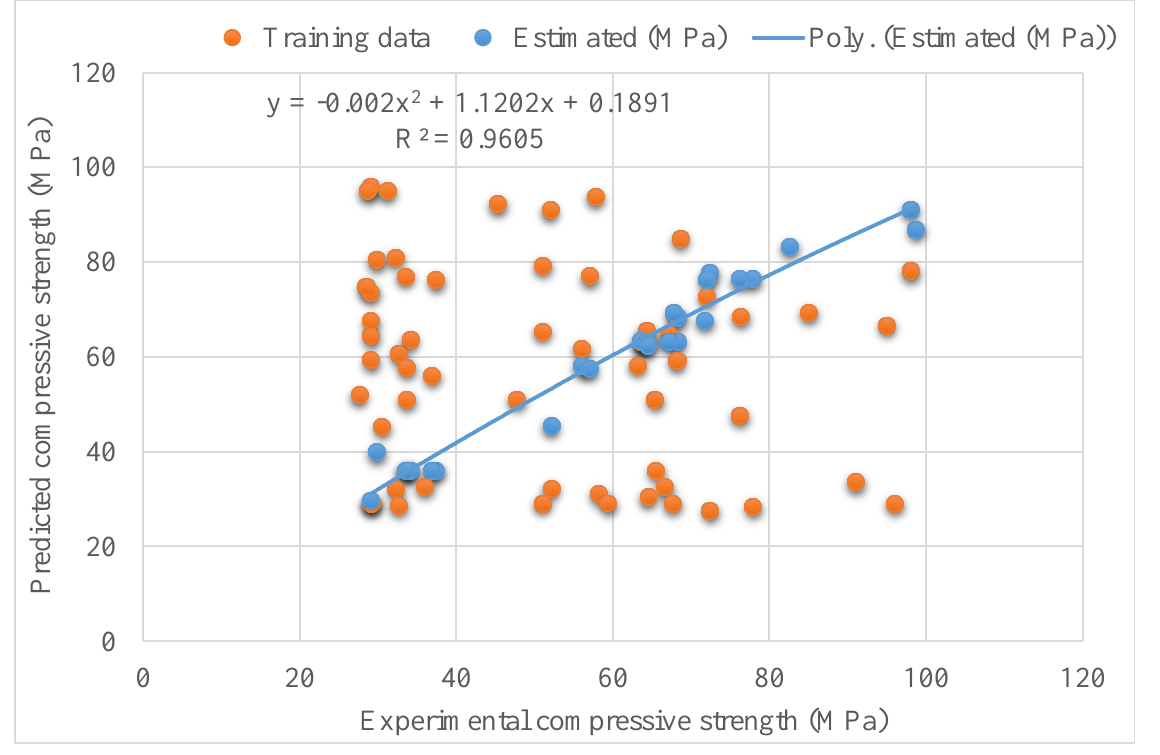
Figure 5. Connection between experimental and estimated results for SVR AdaBoost model.